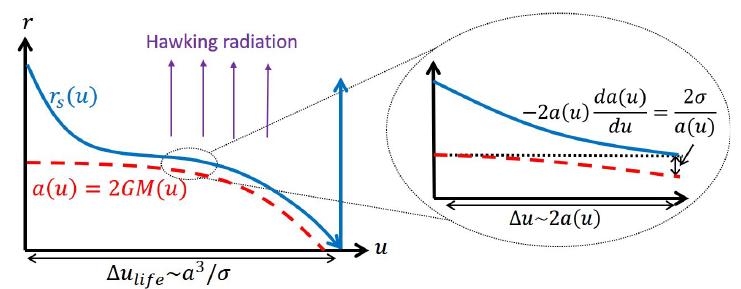
Figure 4. Motion of a particle (or a spherical shell) near the evaporating black hole. r s ( u ) is the position of the particle (or the shell) and a ( u ) is the Schwarzschild radius decreasing as Equation (5). Left: The black hole evaporates before the particle reaches it, and the particle comes back after evaporation. Right: The particle cannot catch up with the Schwarzschild radius a ( u ) due to the back reaction of the